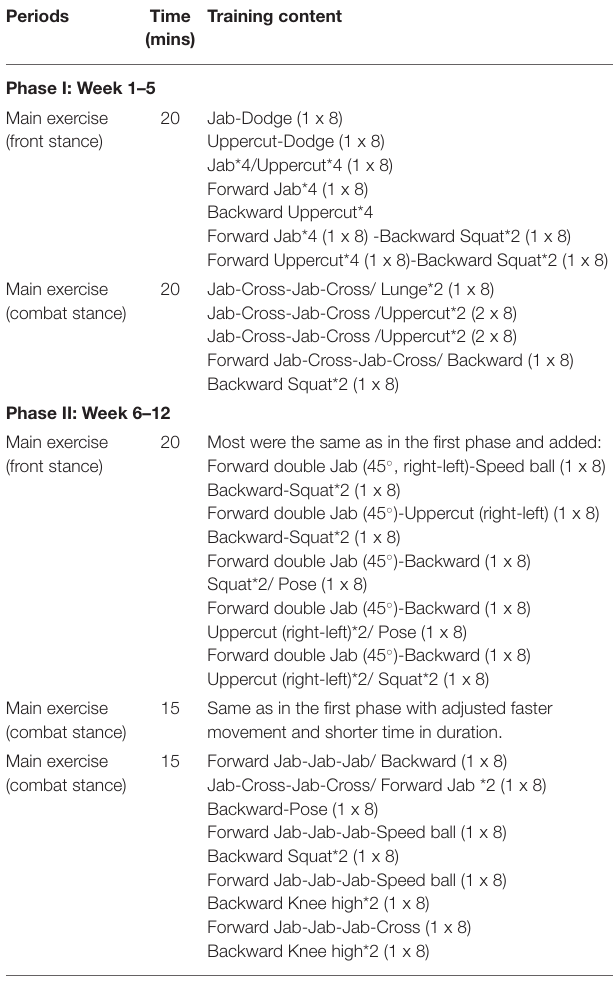
TABLE 1 | Training content for main kickboxing